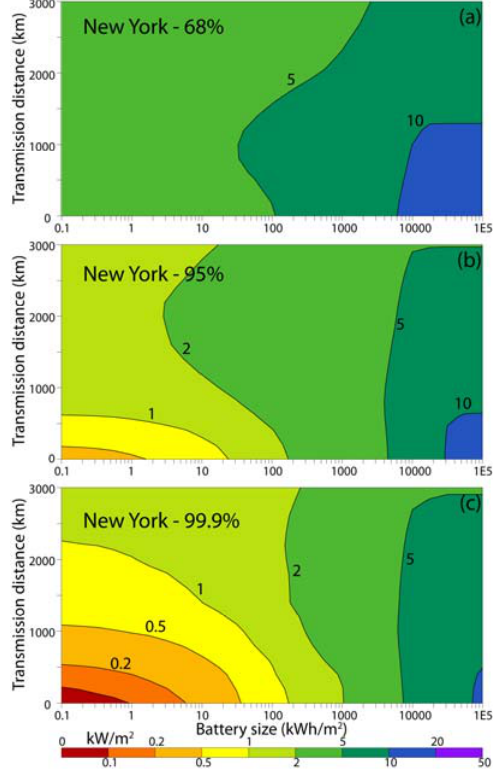
Figure 5. Contours of wind power output per swept area (kW/m 2 ) that can be supplied from optimal high-altitude winds in New York with: (a) 68%, (b) 95%, (c) and 99.9% reliability as a function of battery size (kWh/m 2 , logarithmic scale) and transmission distance